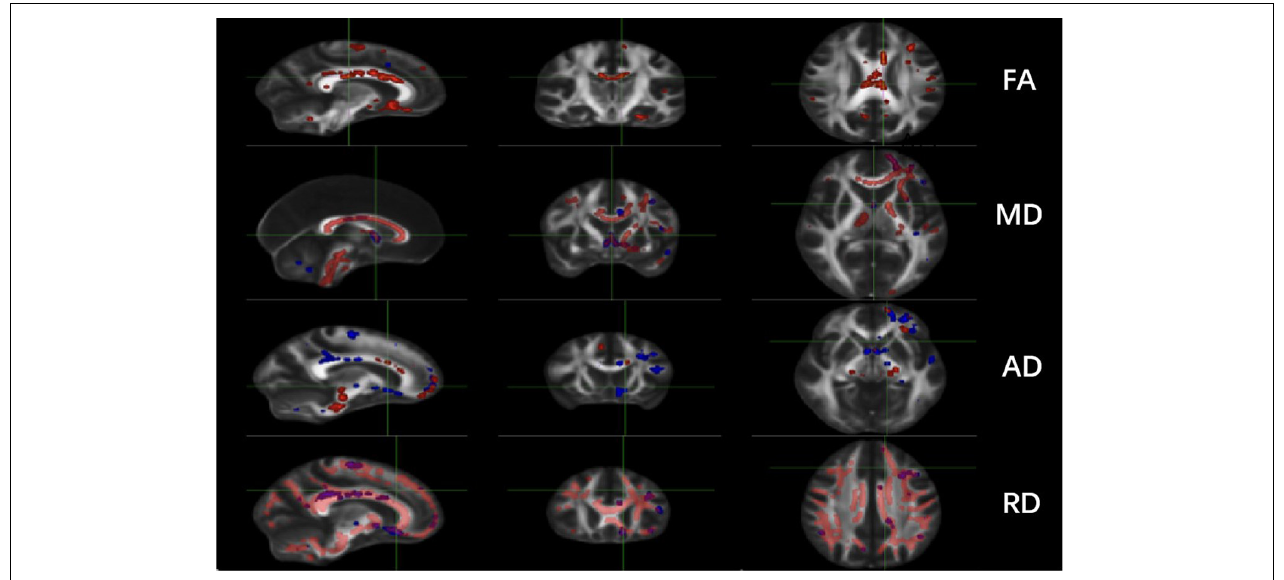
FIGURE 1 | Comparisons of DTI imaging in group analyses of TBSS. Results of TBSS between TT responsive group and TT non-responsive group. Significant region ( P < 0.05) illustrated in warm colors for decreased values and in cool colors for increased values on mean WM skeleton. DTI, diffusion tensor imaging; TBSS, tract-based spatial statistics; FA, fractional anisotropy; MD, mean diffusivity; AD, axial diffusivity; RD, radial diffusivity.